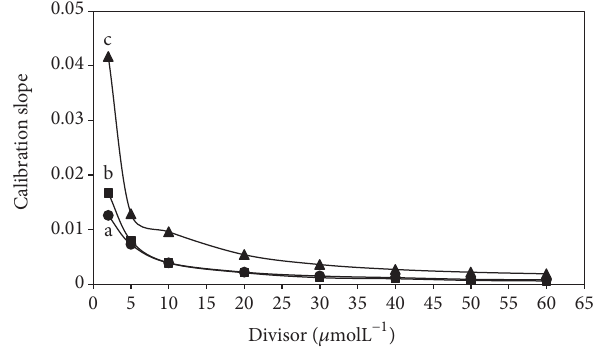
F 8: Effect of double divisor concentrations on the slopes of the calibration curves of (a) ASP, (b) CAF, and (c) PAR.